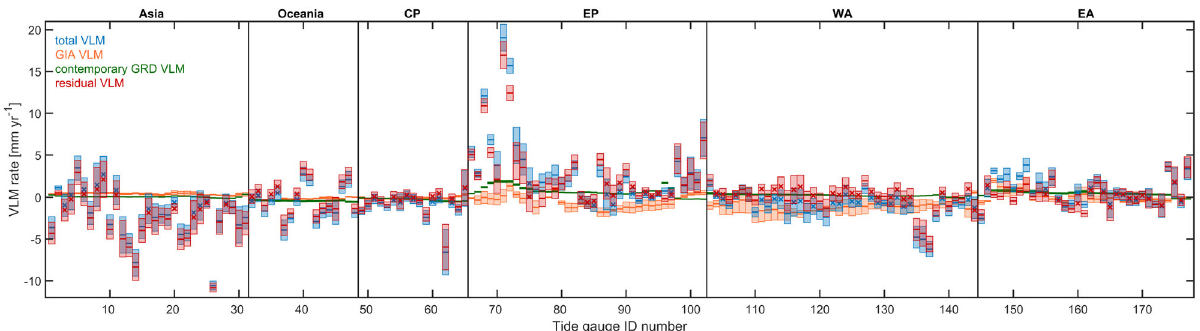
Fig. 4 Estimated rates of total vertical land motion (VLM) and different components at tide-gauge stations. Box plots of total VLM (blue), glacial isostatic adjustment (GIA) VLM (green), contemporary changes in Earth Gravity, Earth Rotation and viscoelastic solid-Earth Deformation (GRD) VLM (orange), and residual VLM (red) rates. Negative (positive) values denote subsidence (uplift). Error bars indicate 90% con fi dence level, and trends, which are not signi fi cant at 90% con fi dence level denoted as cross symbols. Region de fi nition is shown in Fig. 2. trend histogram (green in Fig. 5b bottom panel) having a mean via MVLR (Fig. 5 bottom panel). The weighted mean (by 1/ value nearly at zero. Furthermore, the residual in the trend shows uncertainty squared and hereafter) of all tide-gauge trends (3.6 ± that the tide-gauge observations systematically reveal slightly (but 1.7 mm yr − 1 ; red horizontal line in Fig. 5b bottom panel) is statistically equivalent to the weighted-mean trends from the AR5 not signi fi cantly) higher trends than model projections along the projections under RCP4.5 (3.7 ± 0.9 mm yr − 1 ; blue horizontal line North America East Coast (Fig. 5a bottom panel, TG ID in Fig. 5b bottom panel) over 2007 – 2018, with their residual 107 – 134), while a little lower than projected trend along the NATURE COMMUNICATIONS| (2021) 12:990